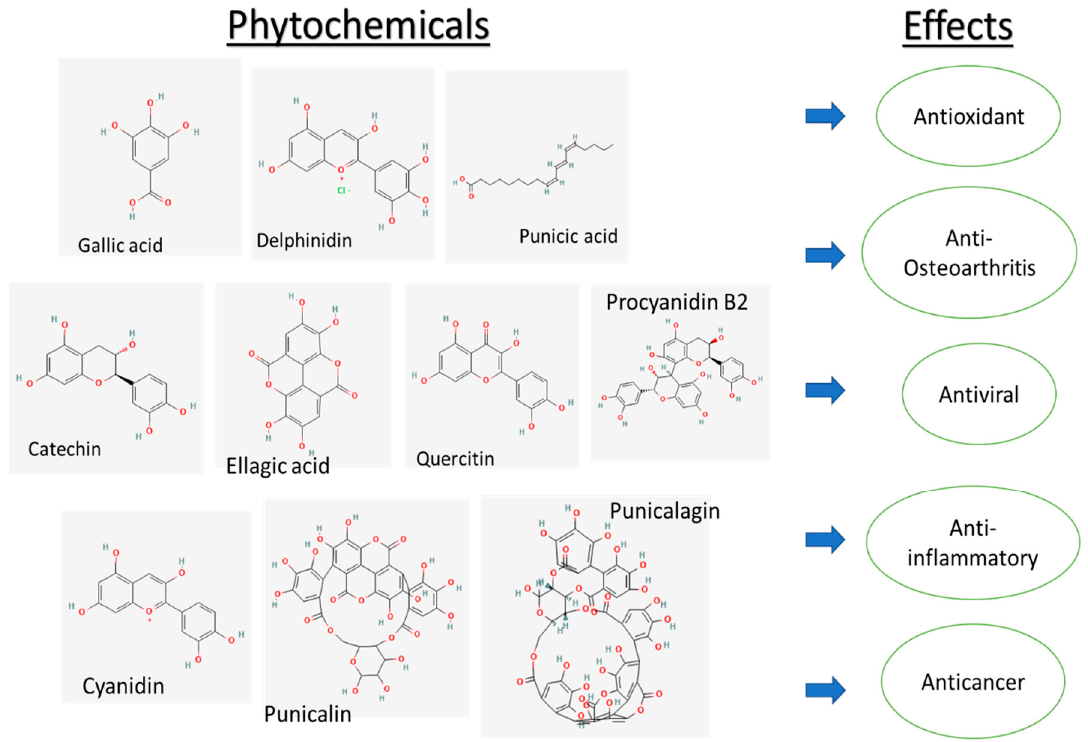
Figure 2. Phytochemicals found in P. granatum and its therapeutic